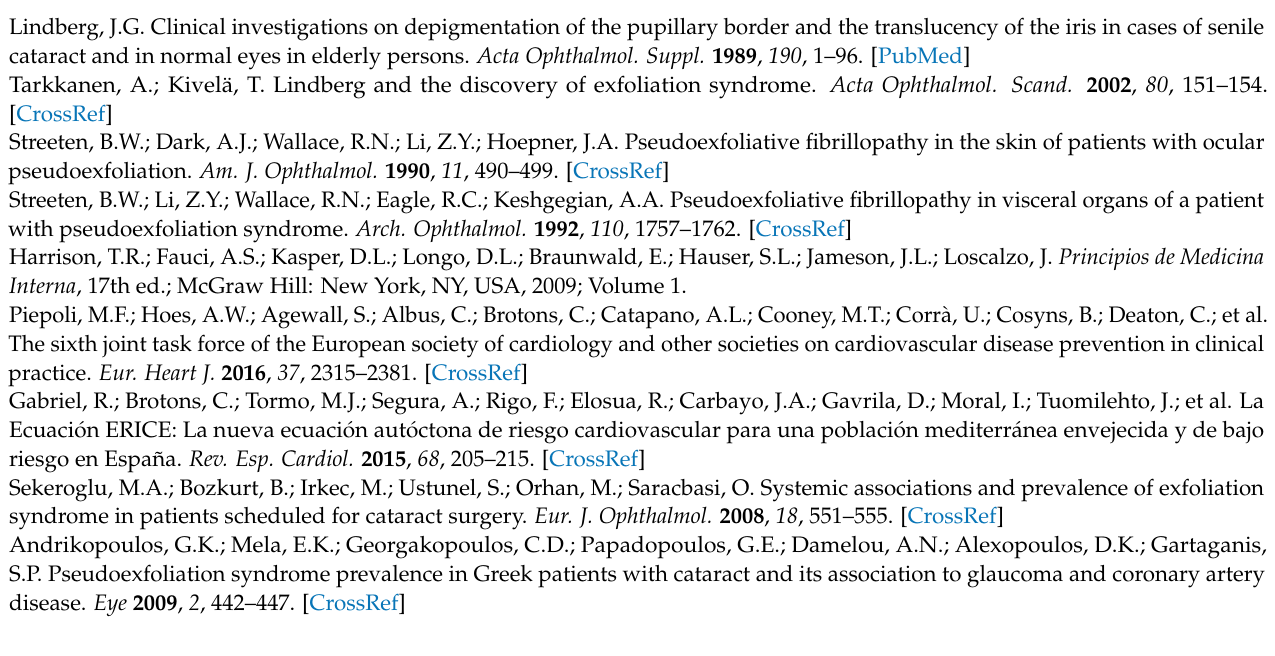
Figure S2: Study